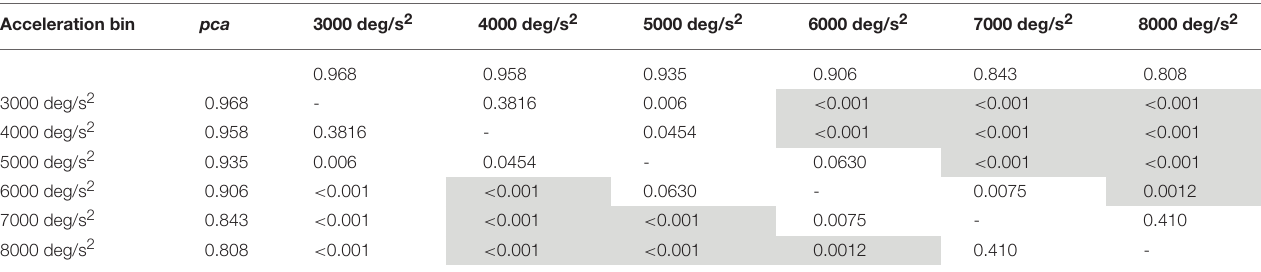
TABLE 5B | Non-ball sports: p -values of the multiple comparisons of pca between head acceleration bin—vertical canals. Acceleration